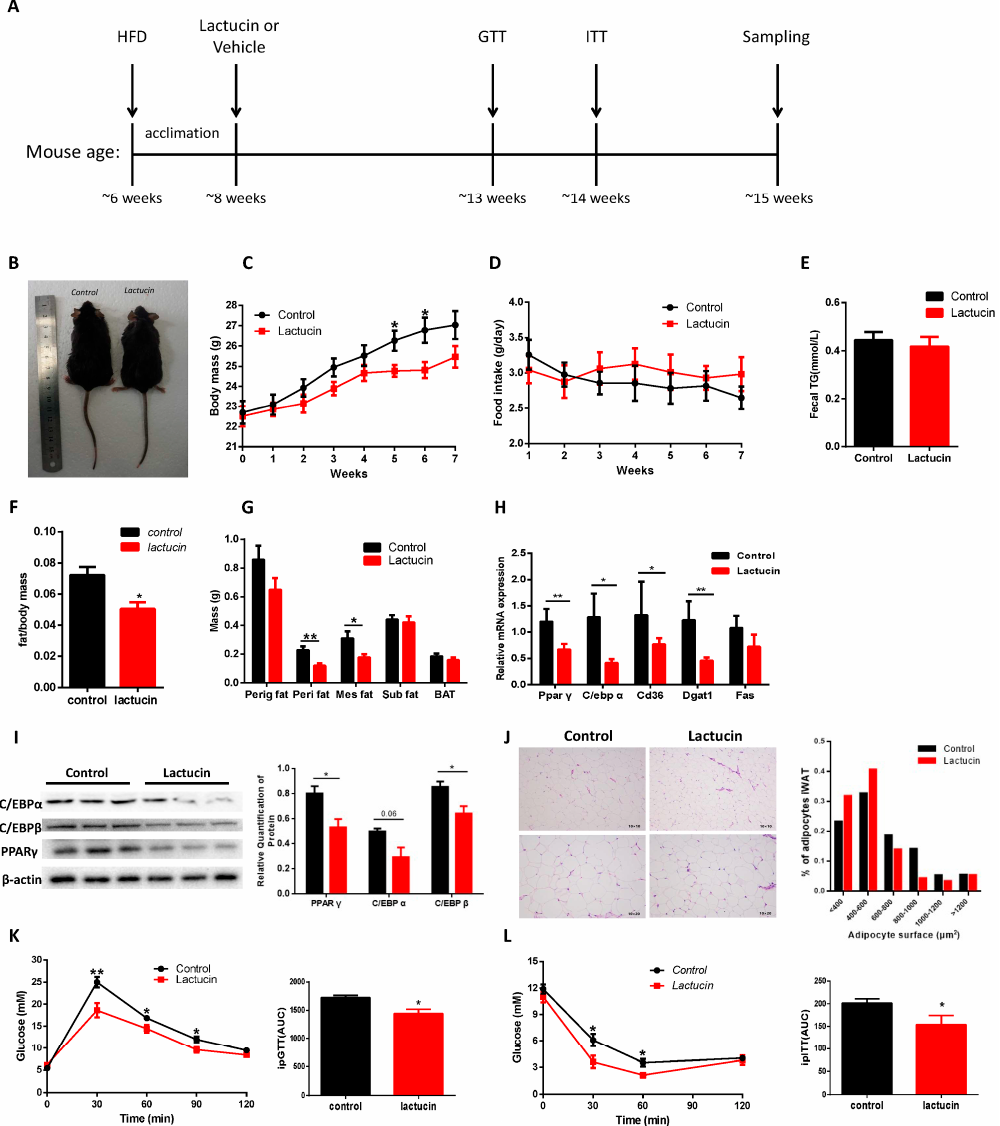
Figure 1. Lactucin treatment prevents HFD-induced obesity in mice. Male C57BL / 6 mice fed a high-fat diet (HFD) were treated with 20 mg / kg / day of lactucin or vehicle by gavage starting from seven weeks of age. ( A ) Schematic diagram of mice treatment. ( B ) Macroscopic views of control and treated mice. ( C ) Weekly body mass ( n = 7). ( D ) Weekly food intake ( n = 7). ( E ) Fecal triglyceride (TG) levels ( n = 7). ( F ) Adipose tissue weight to body weight ratio ( n = 7). ( G ) Mass of fat depots (perigonadal fat, perirenal fat, mesenteric fat, subcutaneous fat, and BAT) ( n = 7). ( H ) The mRNA levels of Ppar γ , C / ebp α , Cd36, Dgat1 and Fas in adipose tissue ( n = 5). ( I ) Protein levels of PPAR γ , C / EBP α , and C / EBP β , as shown by Western blot ( n = 3). ( J ) Histology of iWAT after seven weeks of treatment. ( K ) Blood glucose levels during glucose tolerance tests ( n = 7). ( L ) Blood glucose levels during insulin tolerance tests ( n = 7). Values are mean ± S.E.M. * p < 0.05, ** p < 0.01.